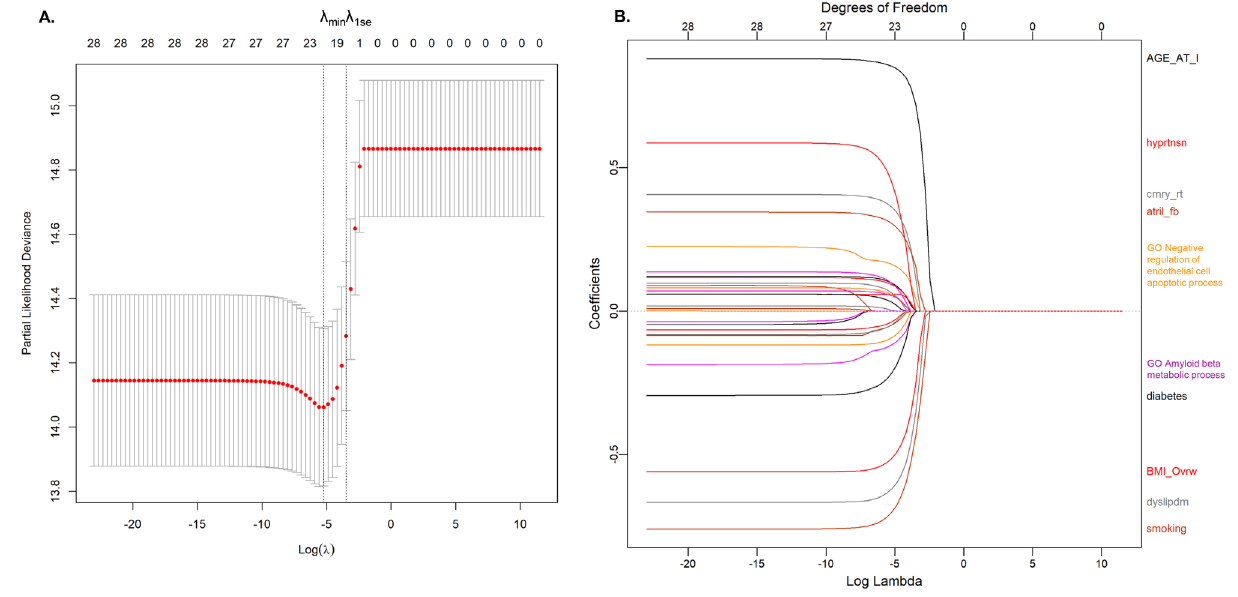
Figure 4. Selection of pathway-specific PRSs using the Least Absolute Shrinkage and Selection Operator (LASSO) Model. Eight clinical and 20 PRS features with p < 0.05 from the univariate CoxPH regression were selected for 3-year mortality. Fit the Regularized (LASSO) Cox Model in the training dataset with fivefold cross-validation for the regression coefficients of PRS and nongenetic variables such as age at index stroke. ( A ) X-tile analysis of the features associated with 3-year mortality with p value < 0.05, respectively. Y-axis represents partial log likelihood ( LL ) deviance from a fivefold cross-validation, Error bar indicate 95% CIs. The left vertical line in (A) showed where the CV-error curve hits its minimum. The right vertical line in ( A ) shows the most regularized model with CV-error within 1 standard deviation of the minimum. We extract such optimal λ’s. ( B ) Regularization path for the progressively shrinking of the regression coefficients of variables by tuning the λ in the LASSO method with fivefold CV. Variables with bigger absolute regression coefficients were listed. The top ten features with the larger effect size were